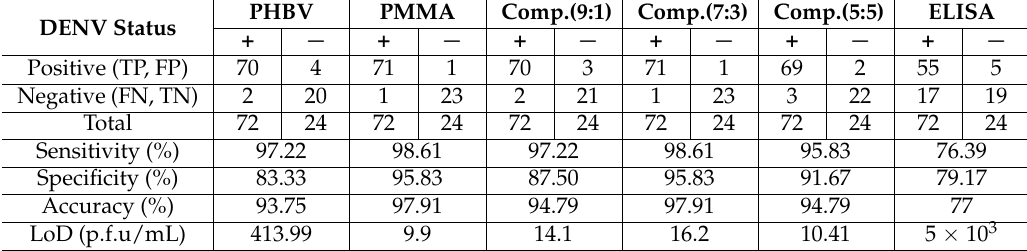
Table 1. Calculated sensitivity, specificity, accuracy and limit of detection (LoD) of the assay performed with polymer-coated electrospun PHBV (poly(3-hydroxybutyrate-co-3-hydroxyvalerate)) fiber mats in DENV (dengue virus) detection (the total number of 432 positive and 144 negative replicates was examined to study the assay accuracy). Indicative parameters in the table are as follows: true